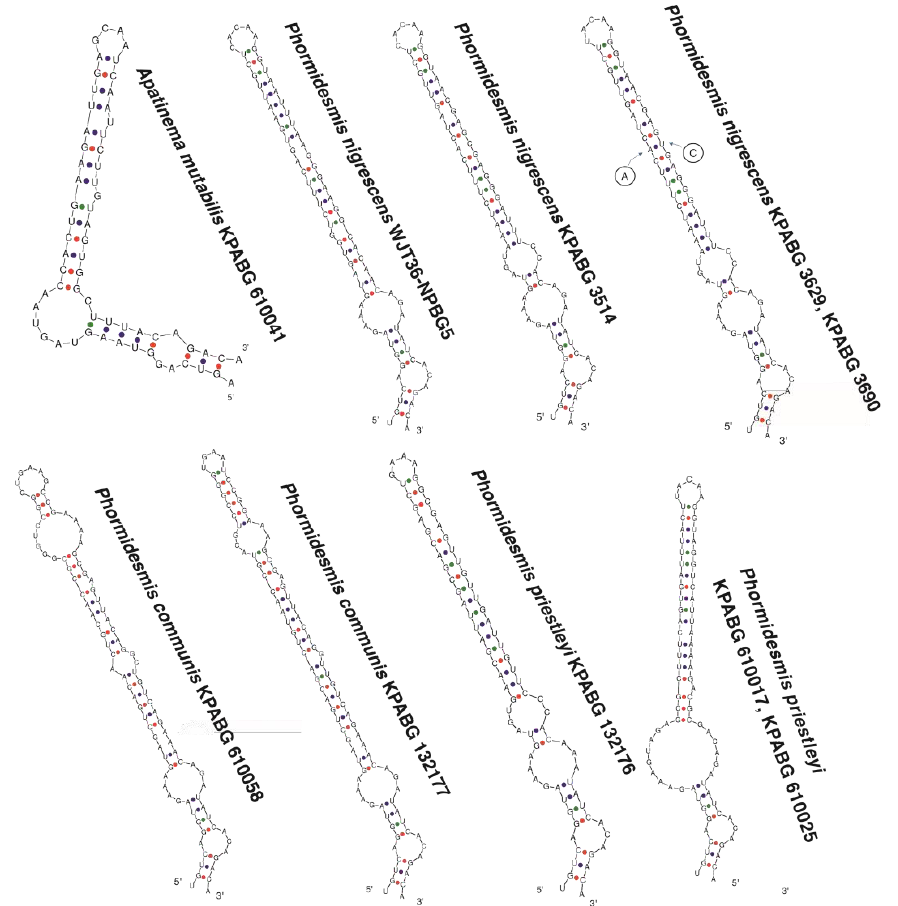
Figure 6. Secondary structure of the V3 helix of the 16S – 23S ITS region. The difference between strains Phormidesmis nigrescens KPABG 3514 and KPABG 3629, KPABG 3690 marked by arrows.